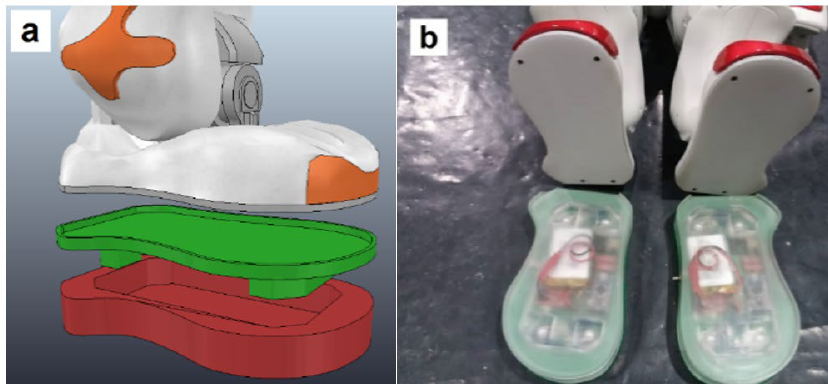
Figure 3. Constituent parts of the virtual instrumented shoes used in the simulations (a), and the real instrumented shoes (b). Note that the shoes follow the original contour of the NAO feet and have two distinct parts: the outer sole (red) and the inner sole (green). The outer sole houses the sensors, communication module, and battery. The force sensors measure the applied force between the outer and the inner sole. The inner sole is fixed to the feet, while the outer sole is responsible for the contact with the floor